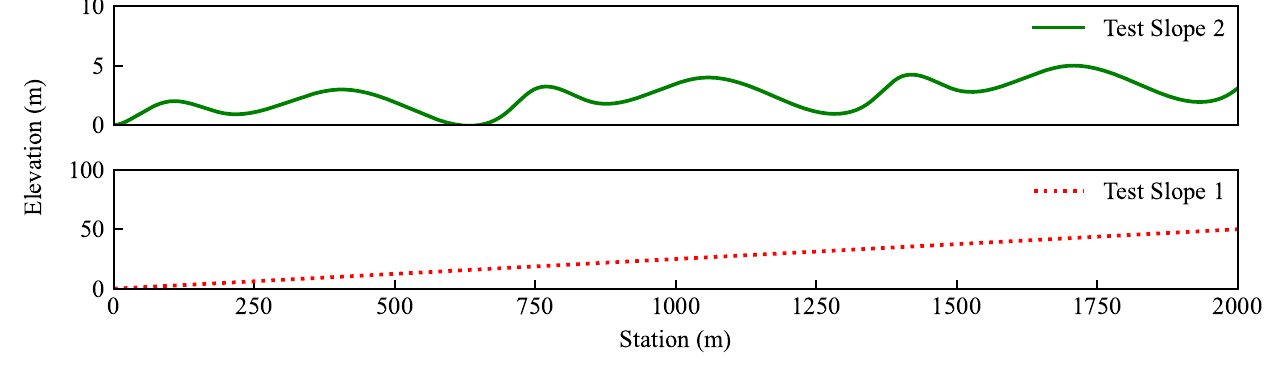
( ) Speed profiles. b : : : ::::: :::::::